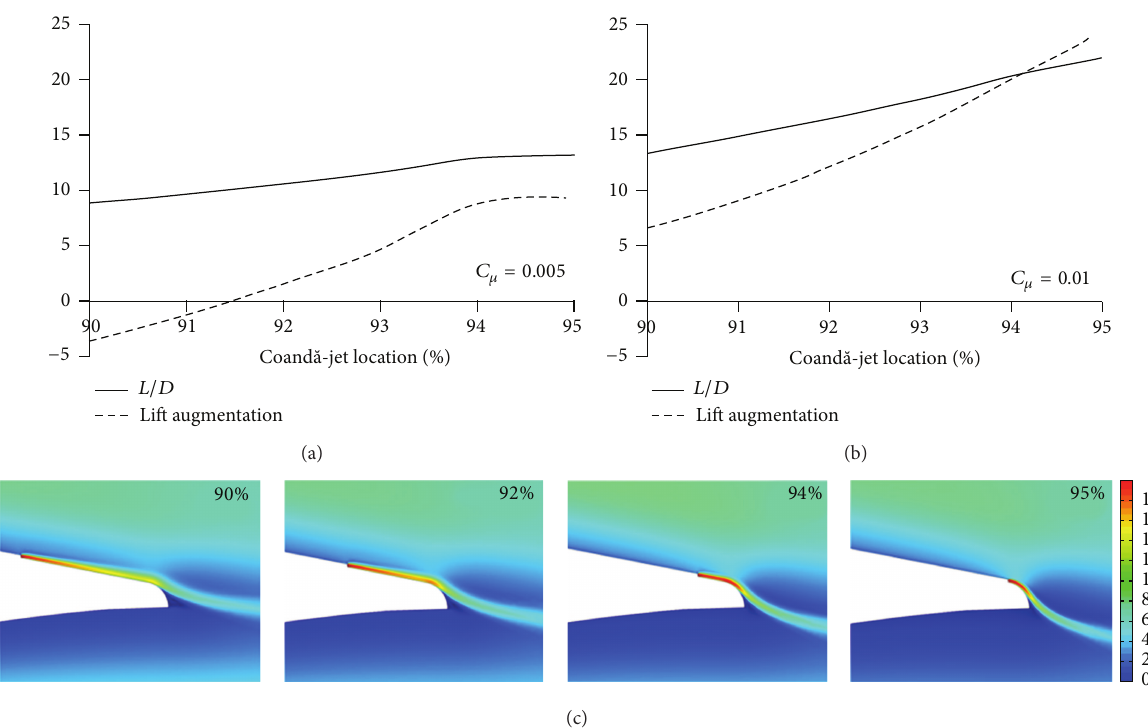
Figure 13: The effect of Coand˘a-jet location on the L / D and lift augmentation (Re = 1 × 10 6 , 𝑅 = 0.010 ; (c) velocity flow field for different Coand˘a-jet location, 𝐶 𝐶 𝜇